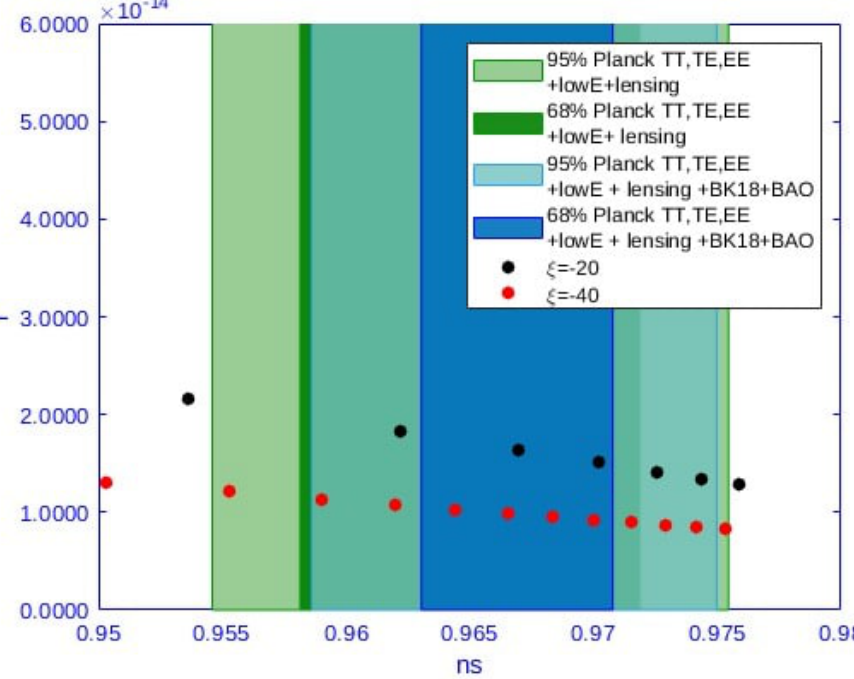
Figure 1. Predictions of warm natural inflation with quadratic NMC to gravity in the strong limit. We took the values in units where Planck mass is unity ( Γ 0 = 7000, f = 5, V 0 = 5 × 10 − 6 ). For the black (red) dots, we have ξ = − 20 ( − 40 ) , φ ∗ ∈ [ 3 × 10 − 4 ,0.0015 ] ( ∈ [ 3 × 10 − 4 ,0.0029 ] ) corresponding to N e ∈ [ 14.8,30.4 ]( ∈ [ 9.3,26.4 ]) . Q in both cases is in the order of 10 3